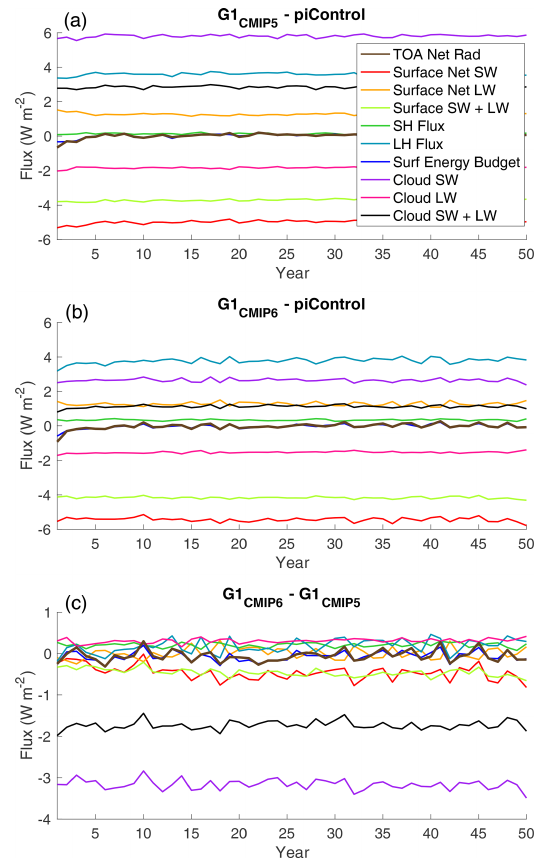
Figure 3. Ensemble mean energetics (Wm − 2 ) for various flux quantities in G1 CMIP5 (a) , G1 CMIP6 (b) , and their difference (c) . All fluxes are positive downward, which is counterintuitive for sen- sible heat (SH) and latent heat (LH). Surf energy budget indicates the sum of surface shortwave (SW), surface longwave (LW), SH, and LH. Cloud forcing is calculated as all-sky minus clear-sky ra- diative